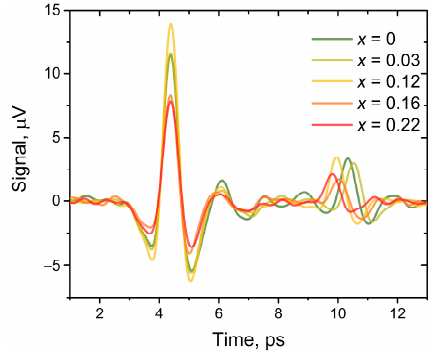
Figure 5. THz waveforms detected with GaSe:S crystals